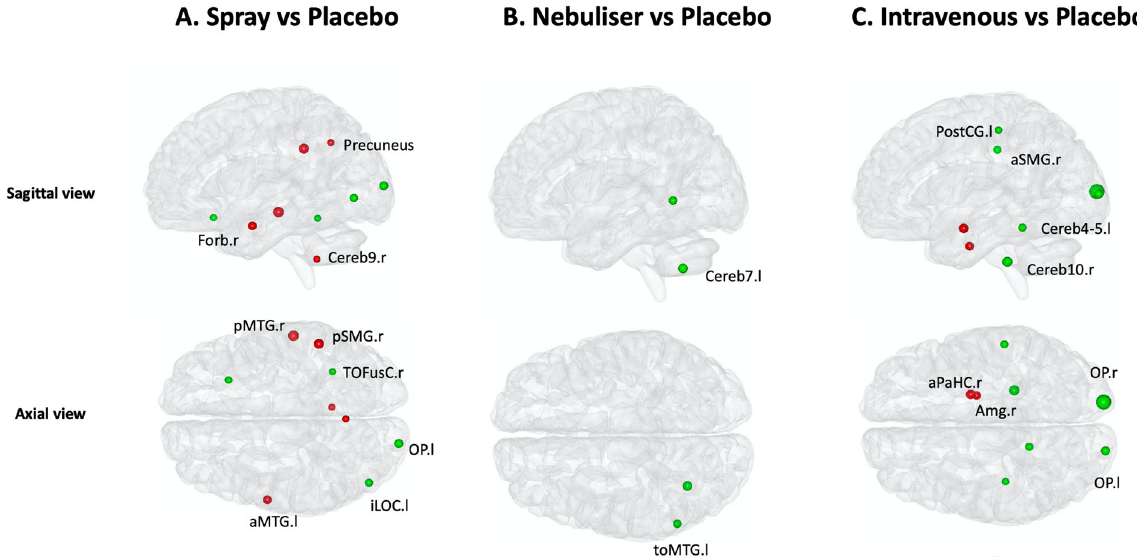
Fig. 2 Effects of exogenous oxytocin on nodal betweenness-centrality. For each node, we compared betweenness-centrality between the four treatment conditions using repeated measures one-way analysis of variance. Since we performed tests for multiple nodes, we controlled false positives using FDR correction for the number of nodes examined. When a signi fi cant effect was found, we explored this effect further using paired t -tests for each pair of treatment groups, correcting for multiple testing using FDR. In this fi gure, we provide an overview of the pattern of changes in betweenness-centrality for each method of administration by showing the results of our post-hoc tests focusing on the comparisons between each active treatment arm and placebo (for direct comparisons between active treatment arms, please refer to Table S1). The green and red colours depict increases and decreases in betweenness-centrality, respectively. The size of each nodal sphere is proportional to the T-statistic of each comparison. The name of each node appears once, in the axial or sagittal view, to avoid cluttering the fi gure. R right, l left, a anterior, p posterior, Forb orbitofrontal cortex, MTG medial temporal gyrus, SMG supramarginal gyrus, TOFusC temporal occipital fusiform cortex, OP occipital pole, iLOC lateral occipital cortex, Cereb Cerebellum; PostCG Postcentral gyrus, Amg Amygdala, aPaHC anterior parahippocampal gyrus, toMTG temporo-occipital area of the middle temporal ef fi ciency of the right superior frontal gyrus, right anterior and posterior medial temporal gyri, right posterior superior temporal gyrus, right cuneal cortex and left cerebellum (area 1) (Fig. 3A